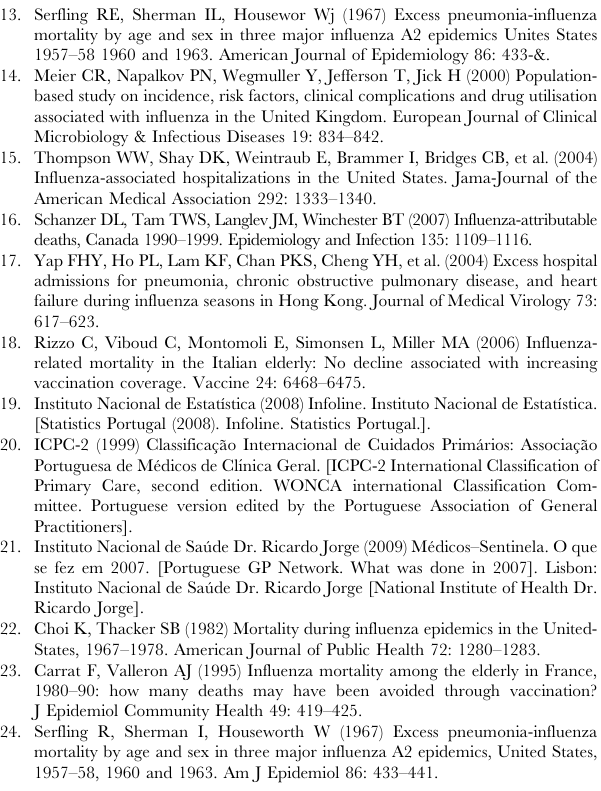
Figure S7 Mortality rates (blue), mortality baseline (black) and 95% confidence limit (red), estimated excess death rate (green) by month and influenza epidemic periods (grey rectangles) for the study causes of death – age group 55–64. Figure S8 Mortality rates (blue), mortality baseline (black) and 95% confidence limit (red), estimated excess death rate (green) by month and influenza epidemic periods (grey rectangles) for the study causes of death – age group 5–54. Figure S9 Mortality rates (blue), mortality baseline (black) and 95% confidence limit (red), estimated excess death rate (green) by month and influenza epidemic periods (grey rectangles) for the study causes of death – age group 0–4. Table S1 Comparison between seasonal ILI attack rates (cumulative rates for week 40–20) and seasonal excess ILI rates occurring during epidemic periods. Rates are per 100,000. Table S2 Correlation matrix between seasonal age- standardized excess mortality rates, cumulative ILI